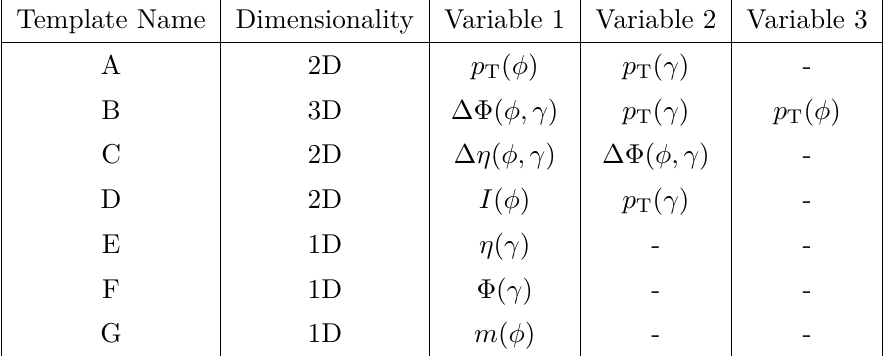
Table 2 . The definition of the set of generation templates from which the components of the pseudo-candidates are sequentially sampled.